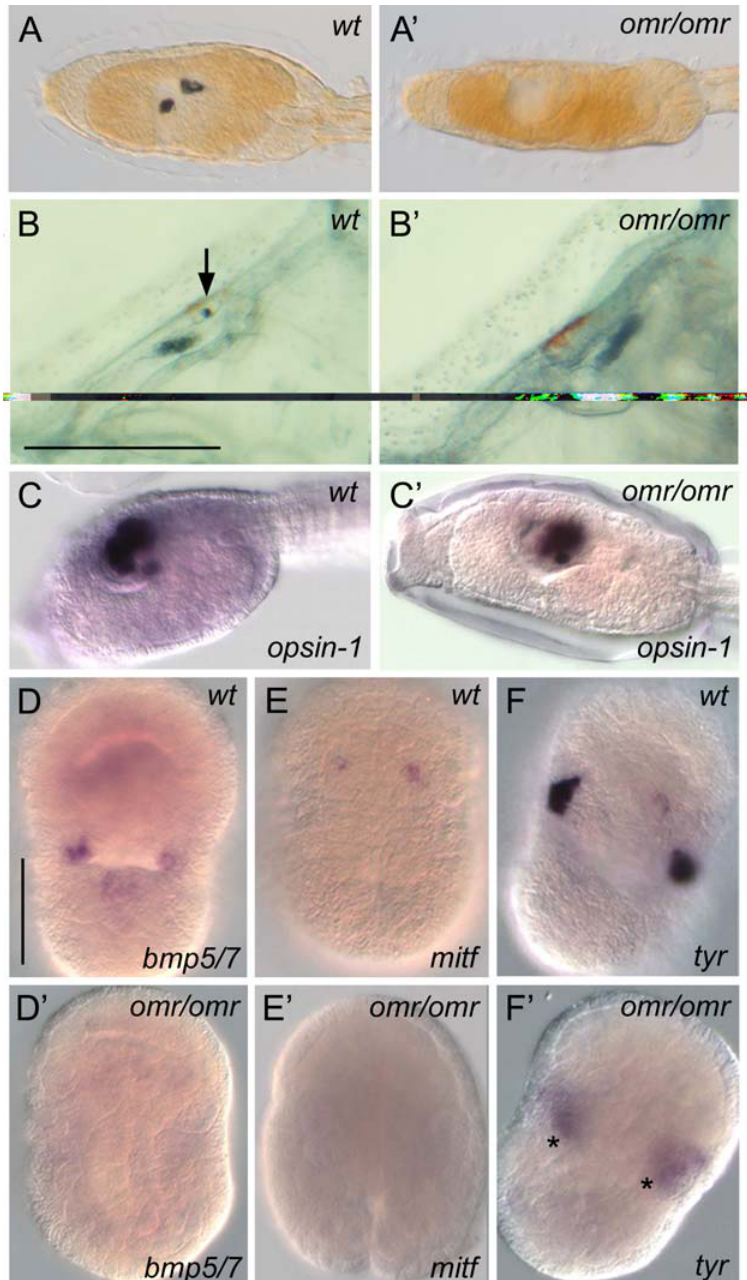
Figure 3. Morphological and molecular traits in wild-type and omero embryos. (A,B) Wild-type larvae and 2 nd juvenile ascidian stage (29 days post fertilization), respectively [41] (black arrow indicates pigment cells in the cerebral ganglion). Scale bar, 100 m m. (A 9 ,B 9 ) Corresponding stages in omero (white arrow points to lack of pigment in the brain). (C,C 9 ) Expression of the photoreceptor marker opsin-1 is unaffected at the larval stage. (D–F 9 ) Conversely, transcriptional patterns of pigment cell specification genes are altered at neurula stage (asterisks highlight background staining in mesenchyme). Scale bar, 50 m m.